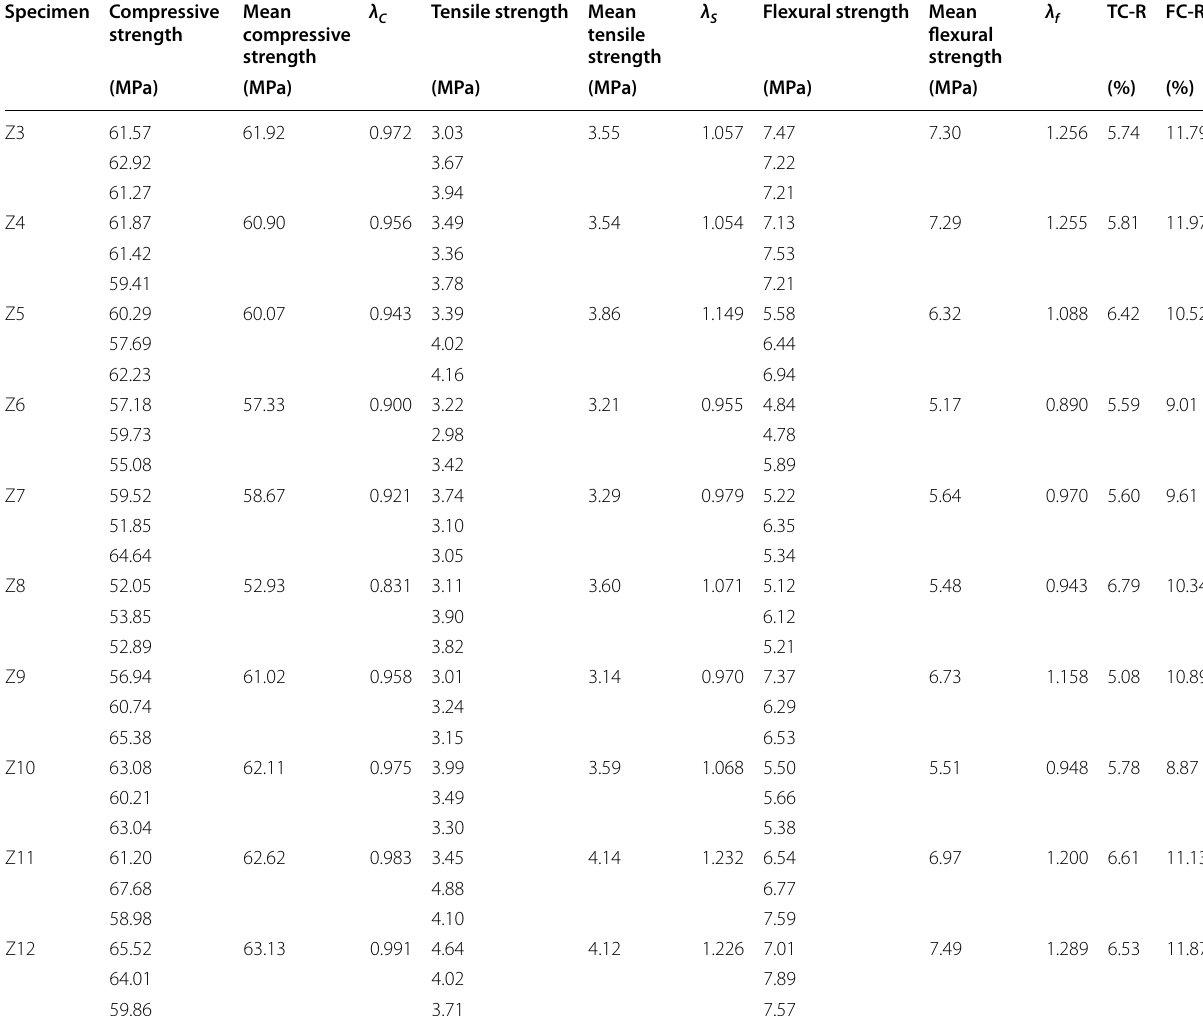
Table 5 Experimental results-2. Specimen Compressive Mean strength